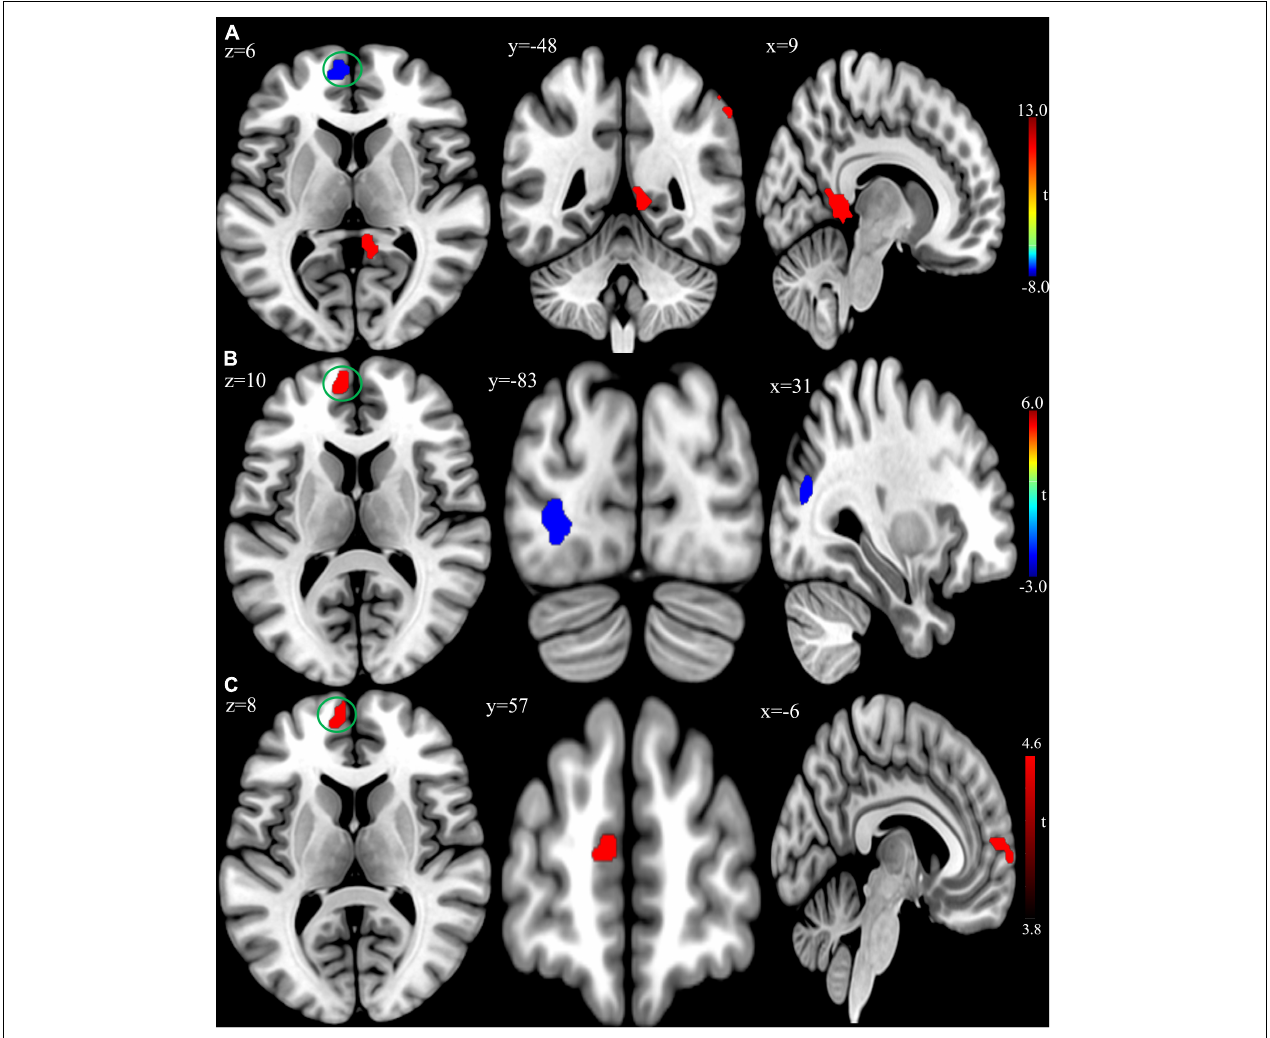
FIGURE 2 | (A) Brain regions showing significant differences of amplitude of low-frequency fluctuation (ALFF) between patient group and healthy control group at baseline. (B) Brain regions showing significant differences of ALFF between the posttreatment and baseline in the patient group. (C) Conjunction analysis maps of ALFF differences [(baseline vs. controls) ∩ (posttreatment vs. baseline)]. The warm color denoted the region where ALFF is higher, and the cool color denotes the region where ALFF is lower. The color circle denoted the overlapped region of ALFF differences.